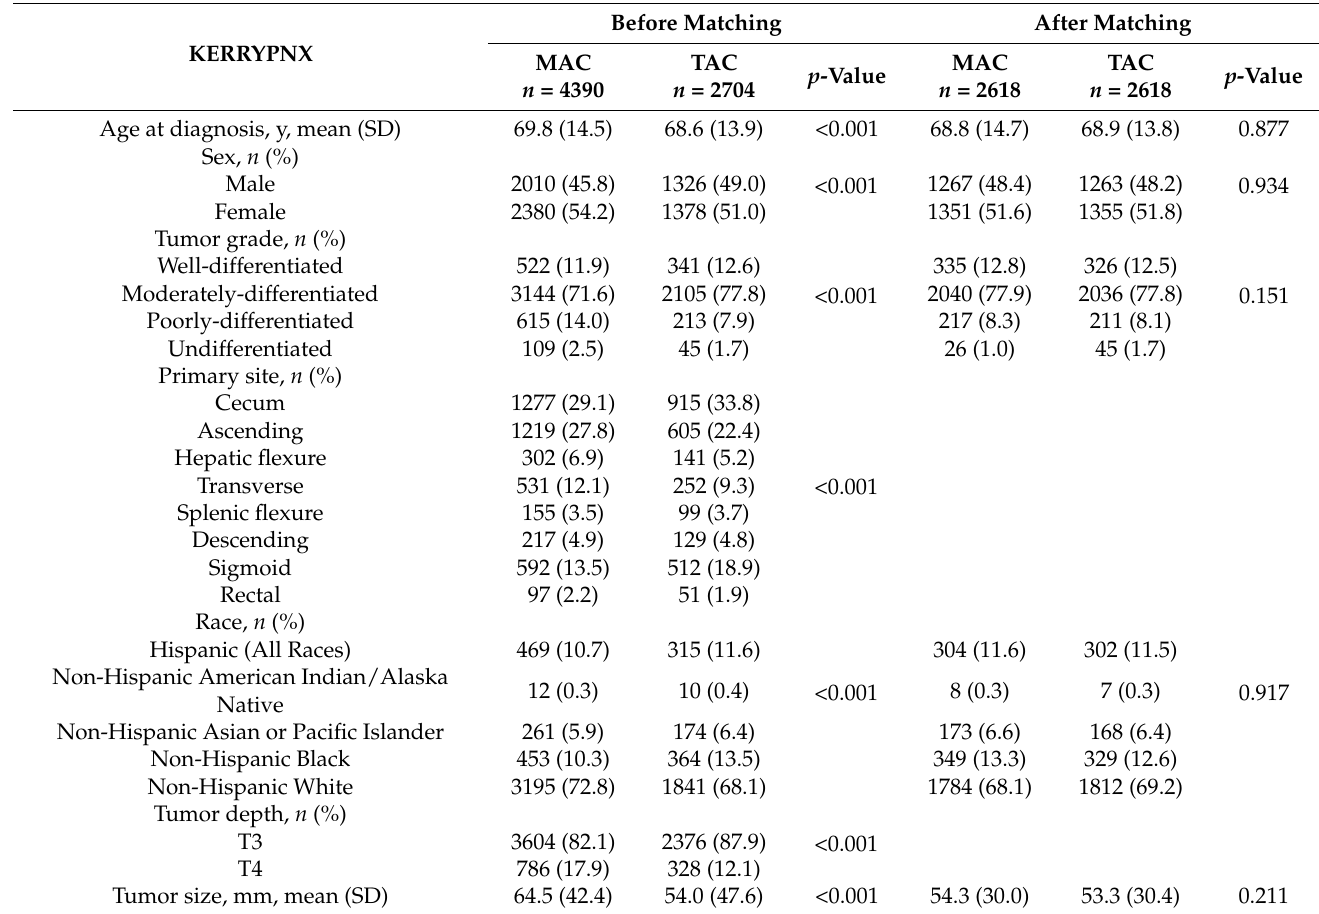
Table 1. Baseline characteristics of the patients with stage II CRC in SEER